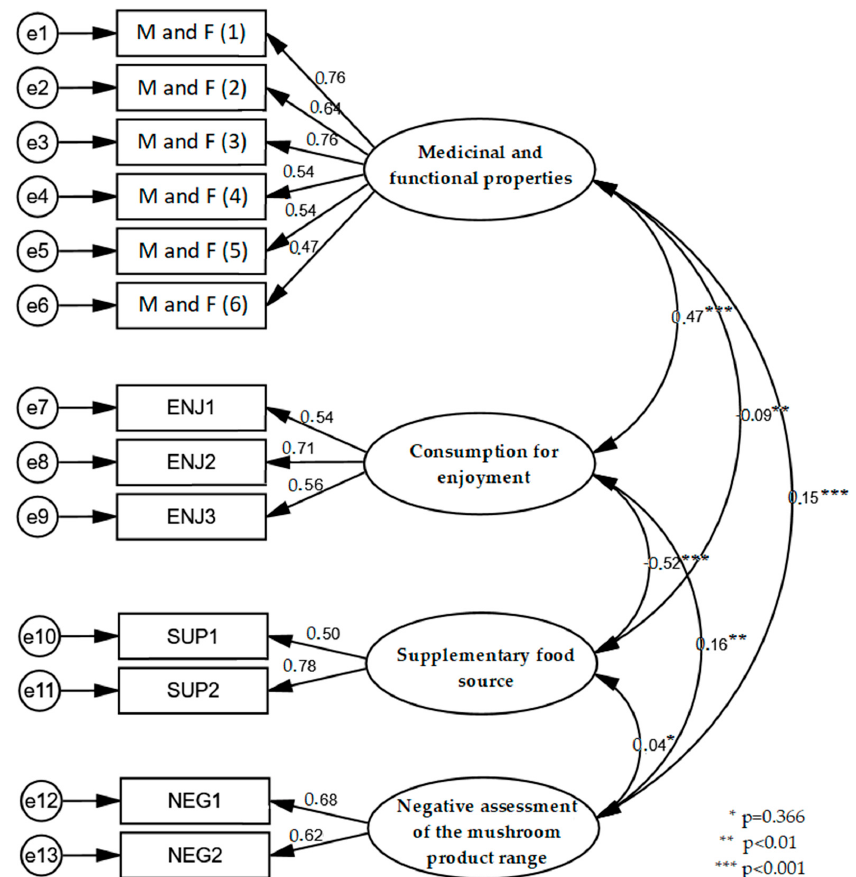
Figure 3. Standardized solution for the model with four factors based on Confirmatory factor analysis (N = 884).